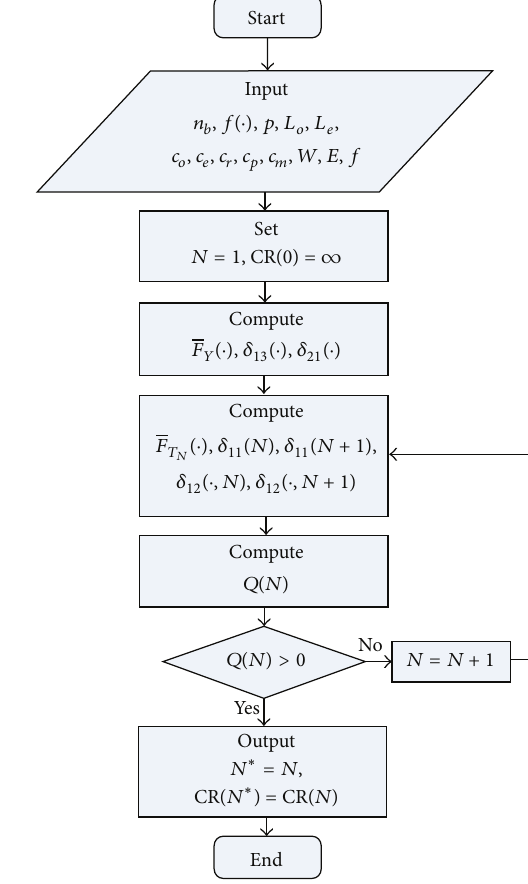
Figure 4: The flow sheet for computation of the optimal